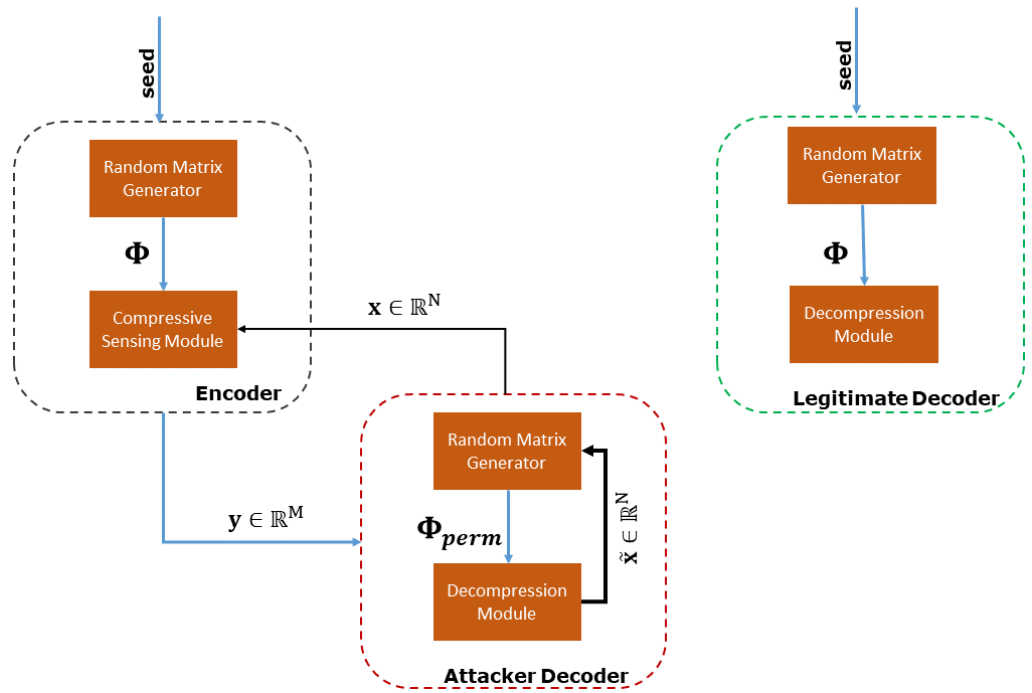
Figure 6. Adversarial scenario in a CS-based